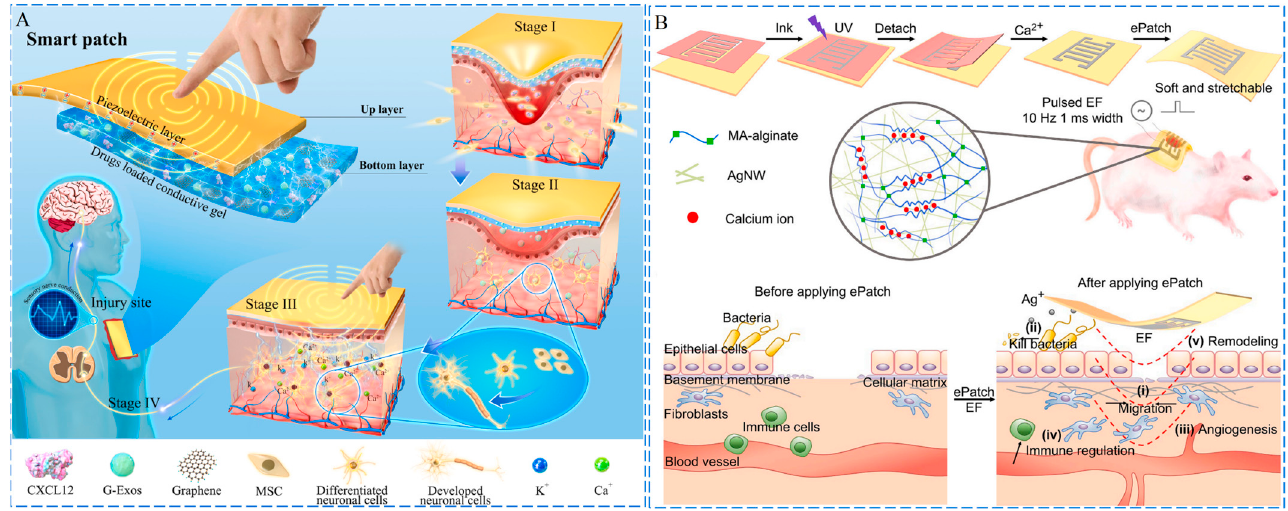
Figure 6. Schematics of the conductive hydrogels. ( A ) Schematics of the hierarchical architecture of the smart patch and its stimulation in endogenous stem cells based neural restoration and sensory function recovery. Adapted with permission [118]. Copyright 2022, Elsevier. ( B ) Schematics of the fabrication of ePatch and five biological activities of the ePatch during the healing process after being applied to wounded SD rats. Adapted with permission [119]. Copyright 2022, Elsevier.